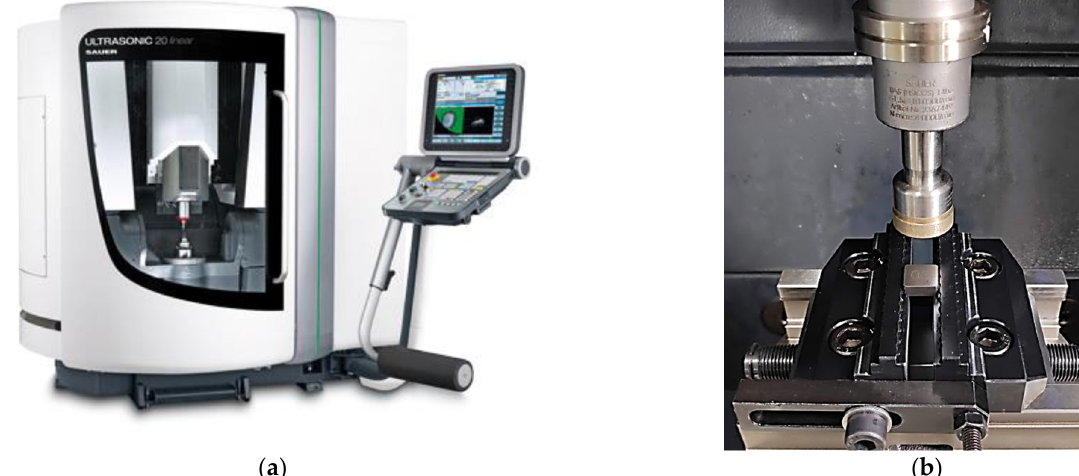
Figure 3. Rotary ultrasonic machining: ( a ) machine tool, ( b ) cutting tool [16].